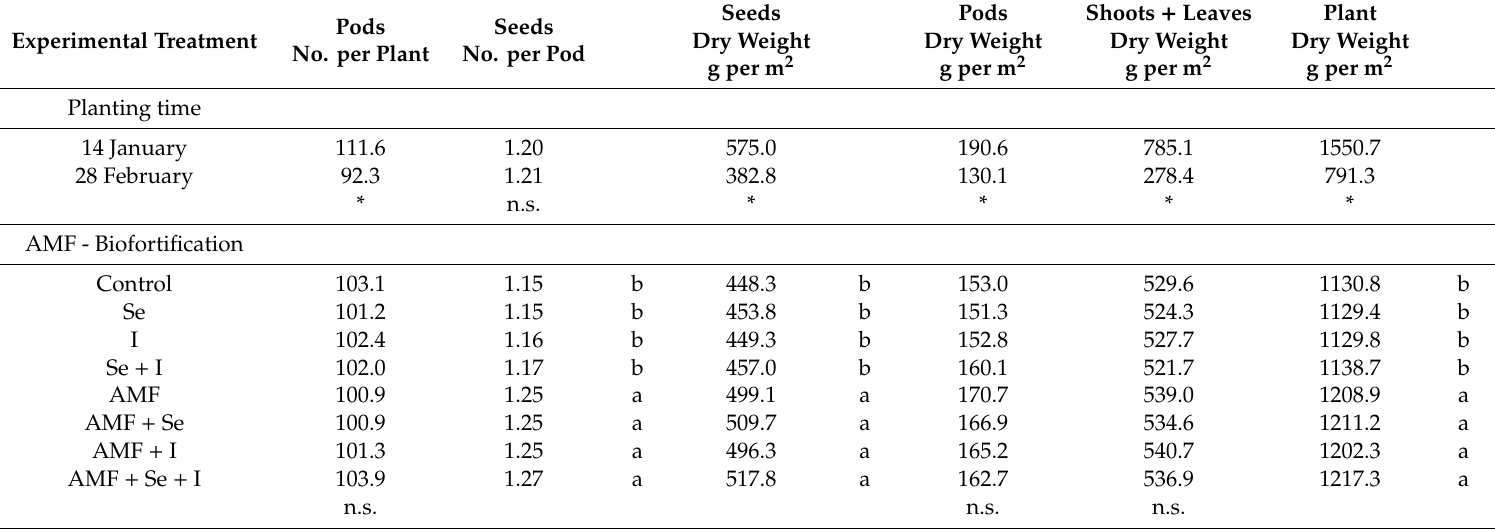
Table 2. Biometrical and growth parameters as a ff ected by planting time and AMF - biofortification. Pods Seeds No. per Plant No. per Pod